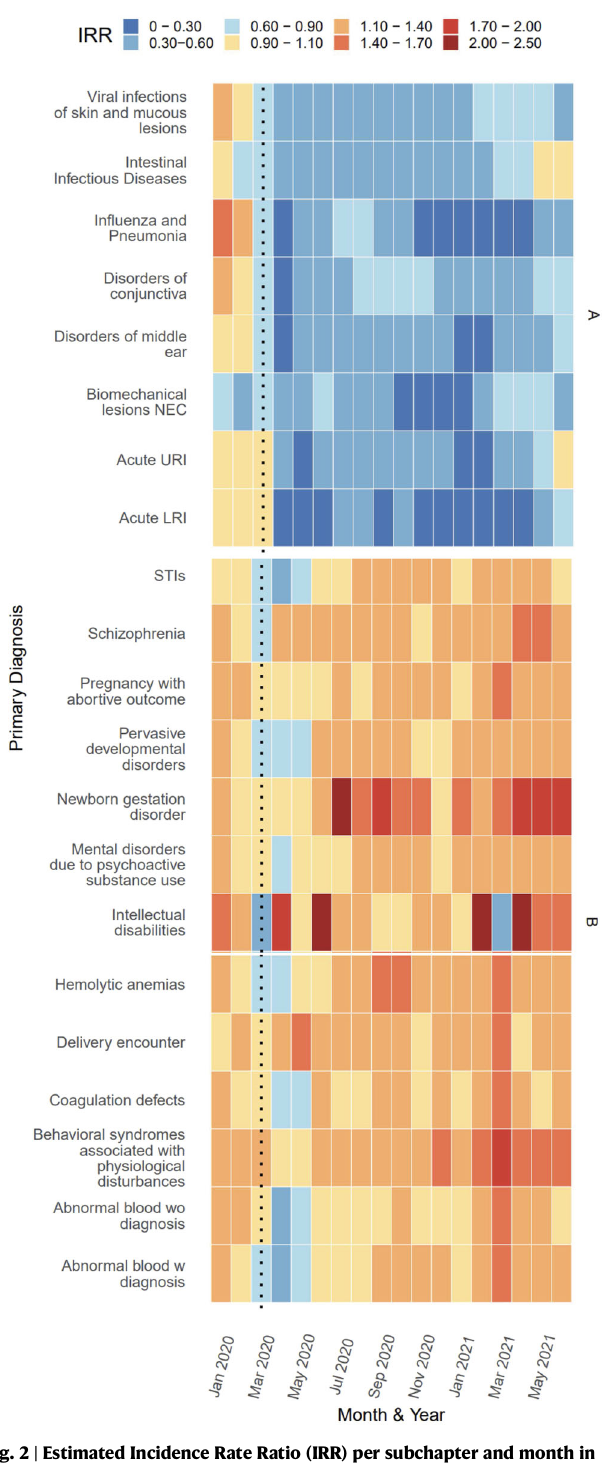
Fig. 2 | Estimated Incidence Rate Ratio (IRR) per subchapter and month in Clusters A and B, Jan 2020 to Jun 2021. Note: Estimates of IRR made by dividing observed by predicted cases per diagnosis per month. Monthly predictions made using trends in previous years data after adjusting for seasonality and time trends with an offset for estimated active population. Prediction intervals for estimates show in Supplementary Figure